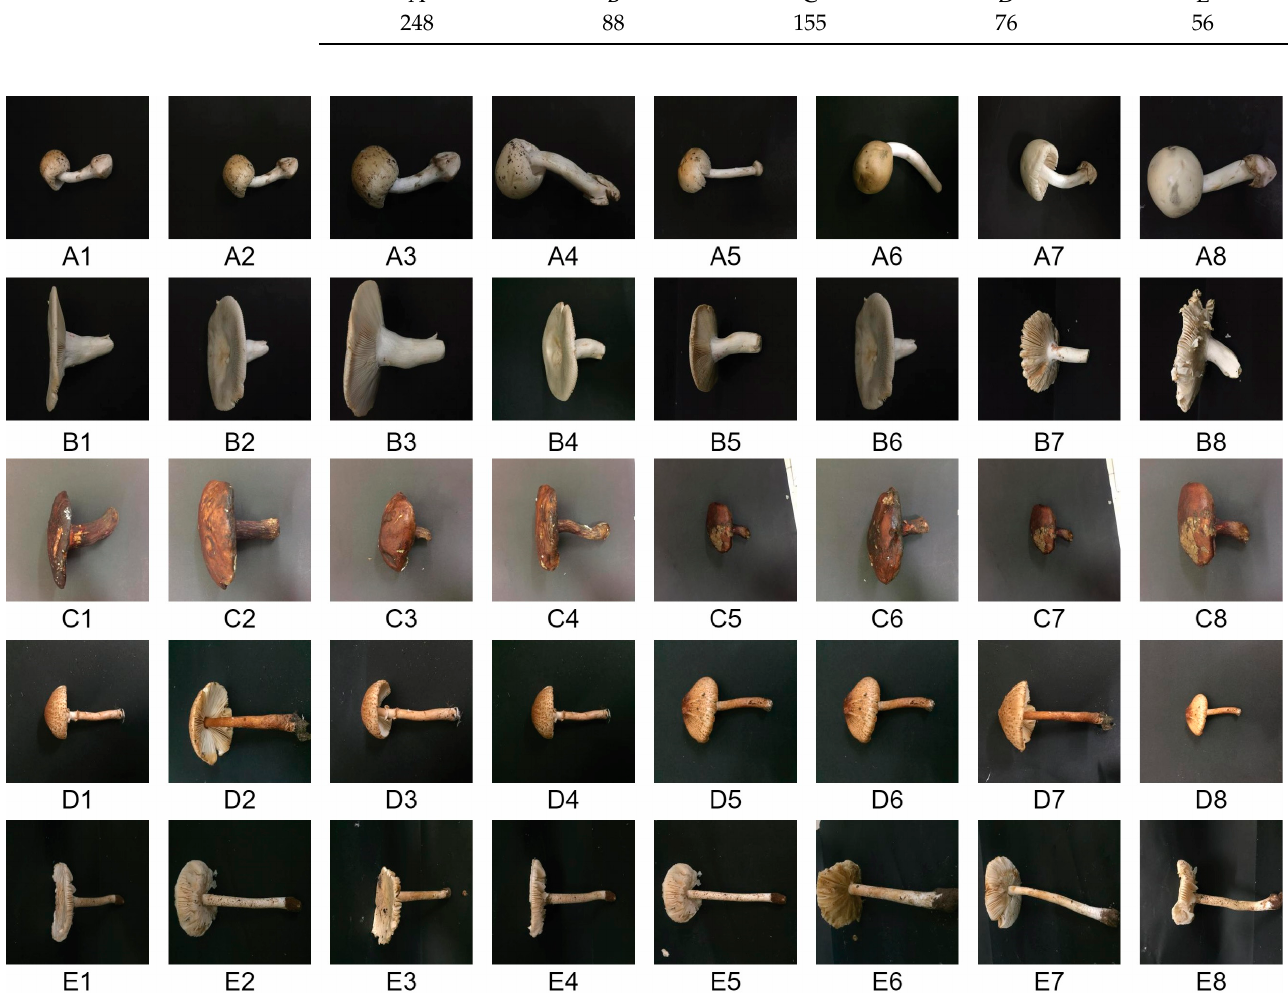
Figure 11. Examples of mushroom images: ( A1 – A8 ) Amanita citrina; ( B1 – B8 ) Russula delica; ( C1 – C8 ) Phaeogyroporus portentosus; ( D1 – D8 ) Inocybe rimosa; ( E1 – E8 ) Amanita phalloides.